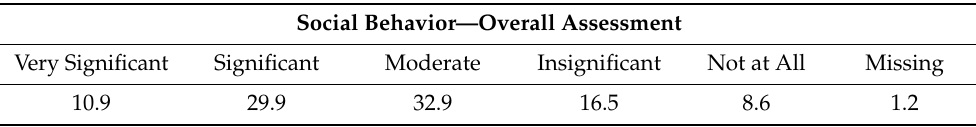
Table 11. Overall assessment of the e ff ects on the social behavior.